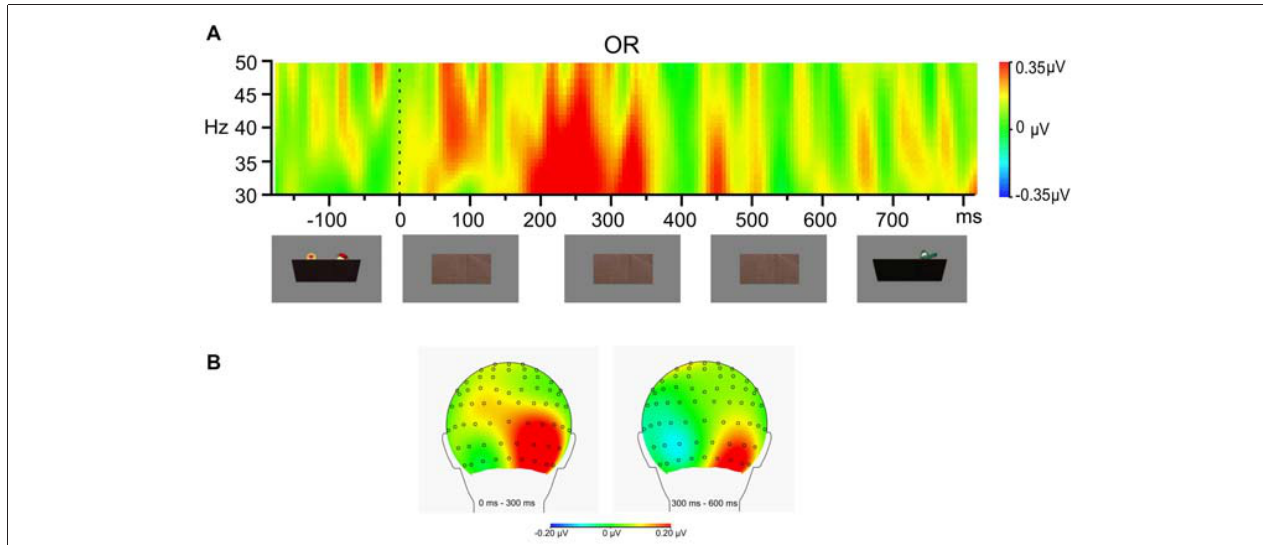
FIGURE 3 | Difference in gamma-band activity between 2-Objection condition and 1-Object condition during stimulus occlusion. (A) Time frequency analysis of the average EEG of the eight electrodes in the pre-defined OR region. (B) Topographical maps of the gamma band (30–50 Hz) activity during the first half (0–300 ms) and the second half (300–600 ms) of the occlusion